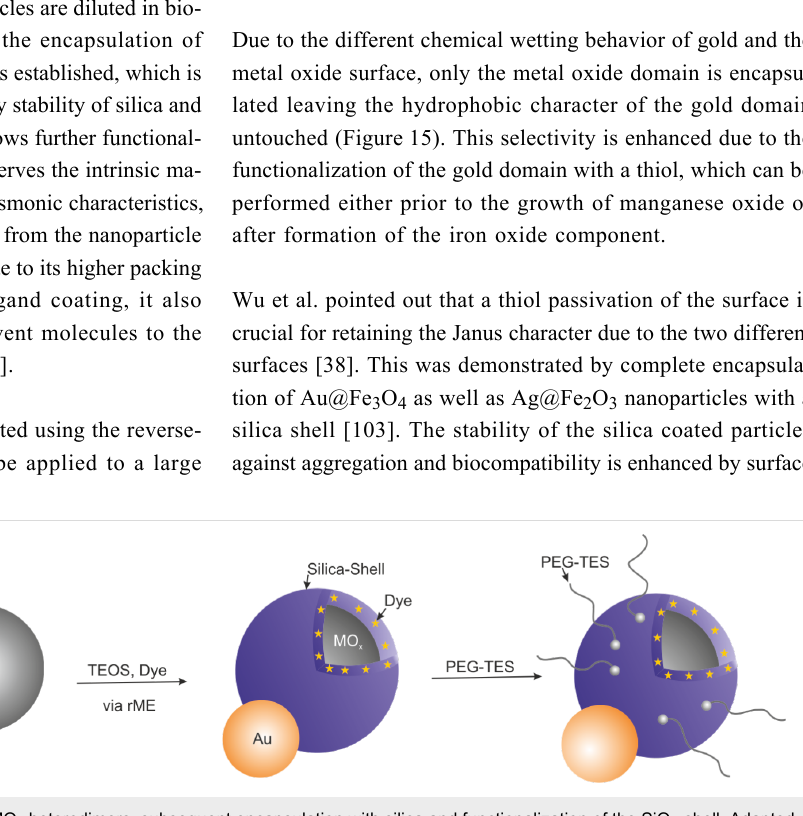
strategies, such as ligand exchange to bind bifunctional or multi-dentate ligands/polymers or the formation of